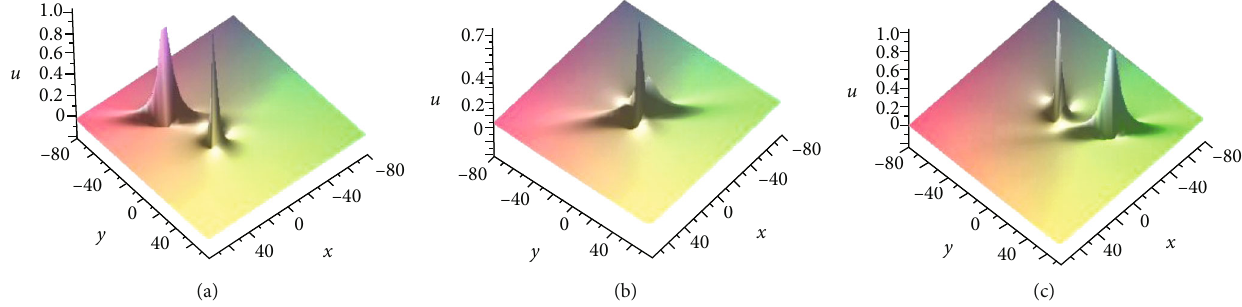
Figure 2: The interaction of two lumps for cKP3-4 equation (2): (a) t = − 4 , (b) t = 0 : 5 , and (c) t = 4